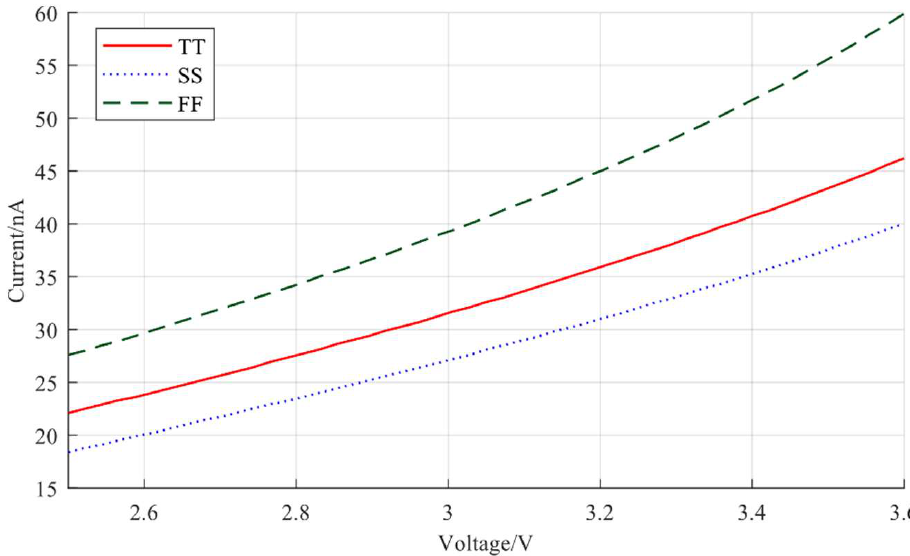
Figure 9. Quiescent current vs. Input Voltage.